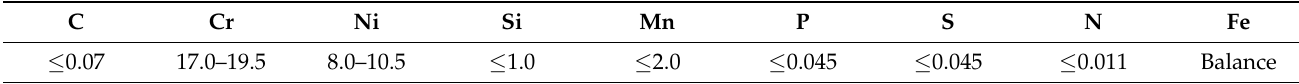
Table 1. Nominal chemical composition of the AISI 304 steel (in wt.%).